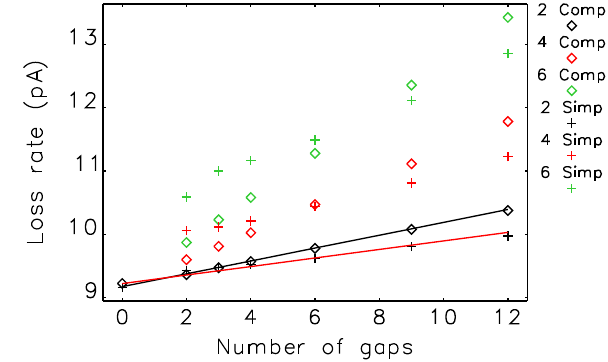
FIG. 18. Harmonic-cavity phase of each unique bunch for the case of 12 simple gaps (uniform bunch charge) and 12 compen- sated gaps.